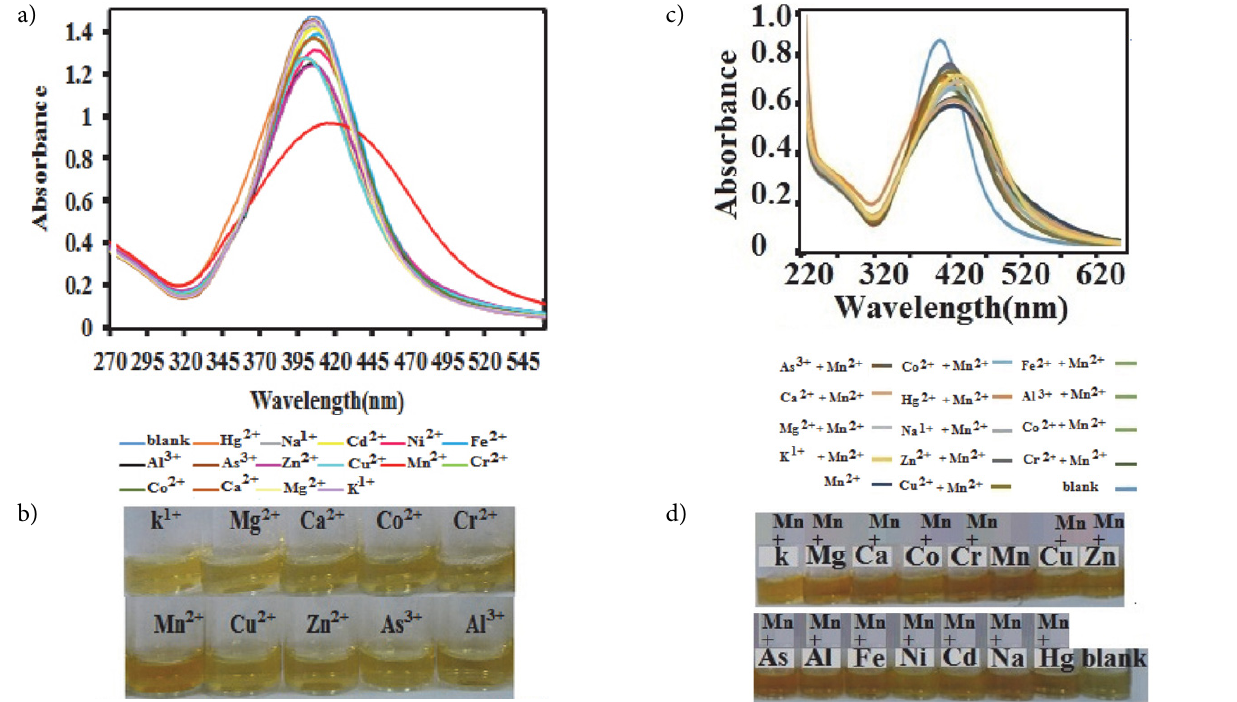
Figure 5. Selectivity of the SDS-AgNPs for Mn 2+ compared with other ions: (a) UV-vis spectra; (b) photographic images for detecting AgNPs incu- bated with K + (50 µM), Cu 2+ (50 µM), Hg 2+ (50 µM), or other ions (50 µM) at pH 7; (c) UV-vis spectra; and (d) Photographic image of detecting SDS-AgNPs incubated with mixture of Mn 2+ (5 µM) and other ions (5 µM) at pH